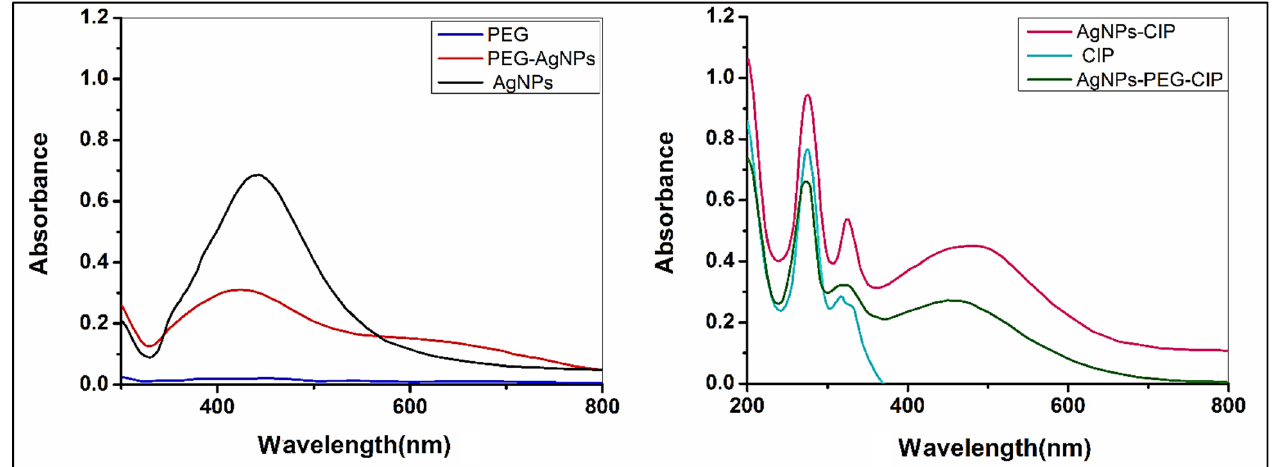
Figure 5. UV-Visible spectrum of AgNPs, CIP, PEG, and their